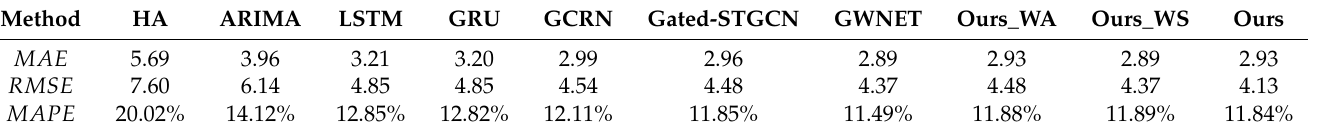
Table 1. The traffic forecasting results under different models with 30 min forecasting interval.